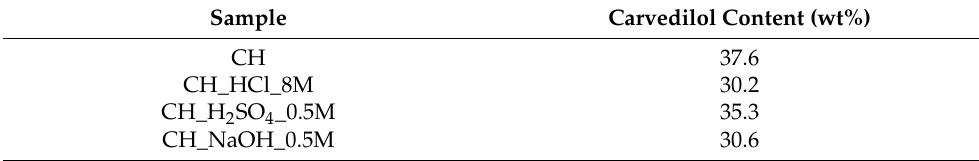
Table 5. Carvedilol content (wt%) determined by UV–Vis